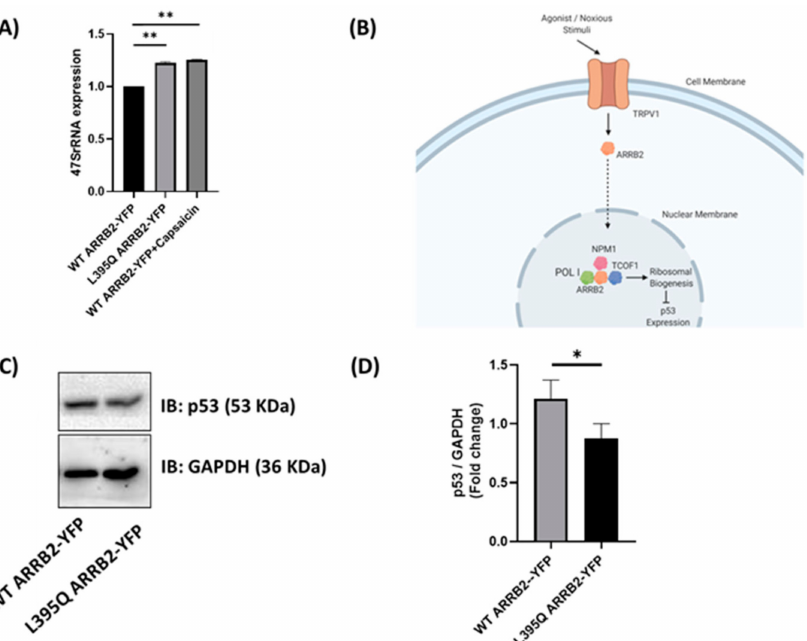
Figure 5. ARRB2 localization affects p53 expression. ( A ) Expression of 47S pre-rRNA, normalized to GAPDH, in neuro2a cells transfected with L395Q ARRB2-YFP or WT ARRB2-YFP with or without 1 µ M capsaicin. Bar graphs represent three independent experiments. Statistical analyses were performed using Kruskal–Wallis followed by Dunn’s post hoc test; ** p < 0.01. ( B ) A schematic diagram of the proposed pathway for the regulation of p53 expression by ARRB2 through interaction with the ribosomal biogenesis machinery. Figure was created using BioRender. ( C ) Western blot analysis of p53 in neuro2a cells transfected with WT ARRB2-YFP or L395Q ARRB2-YFP. ( D ) Bar chart representing the protein expression level of p53 (normalized to GAPDH) illustrated in C. Statistical analyses were performed using Mann–Whitney U test; * p < 0.05. N = 4 independent